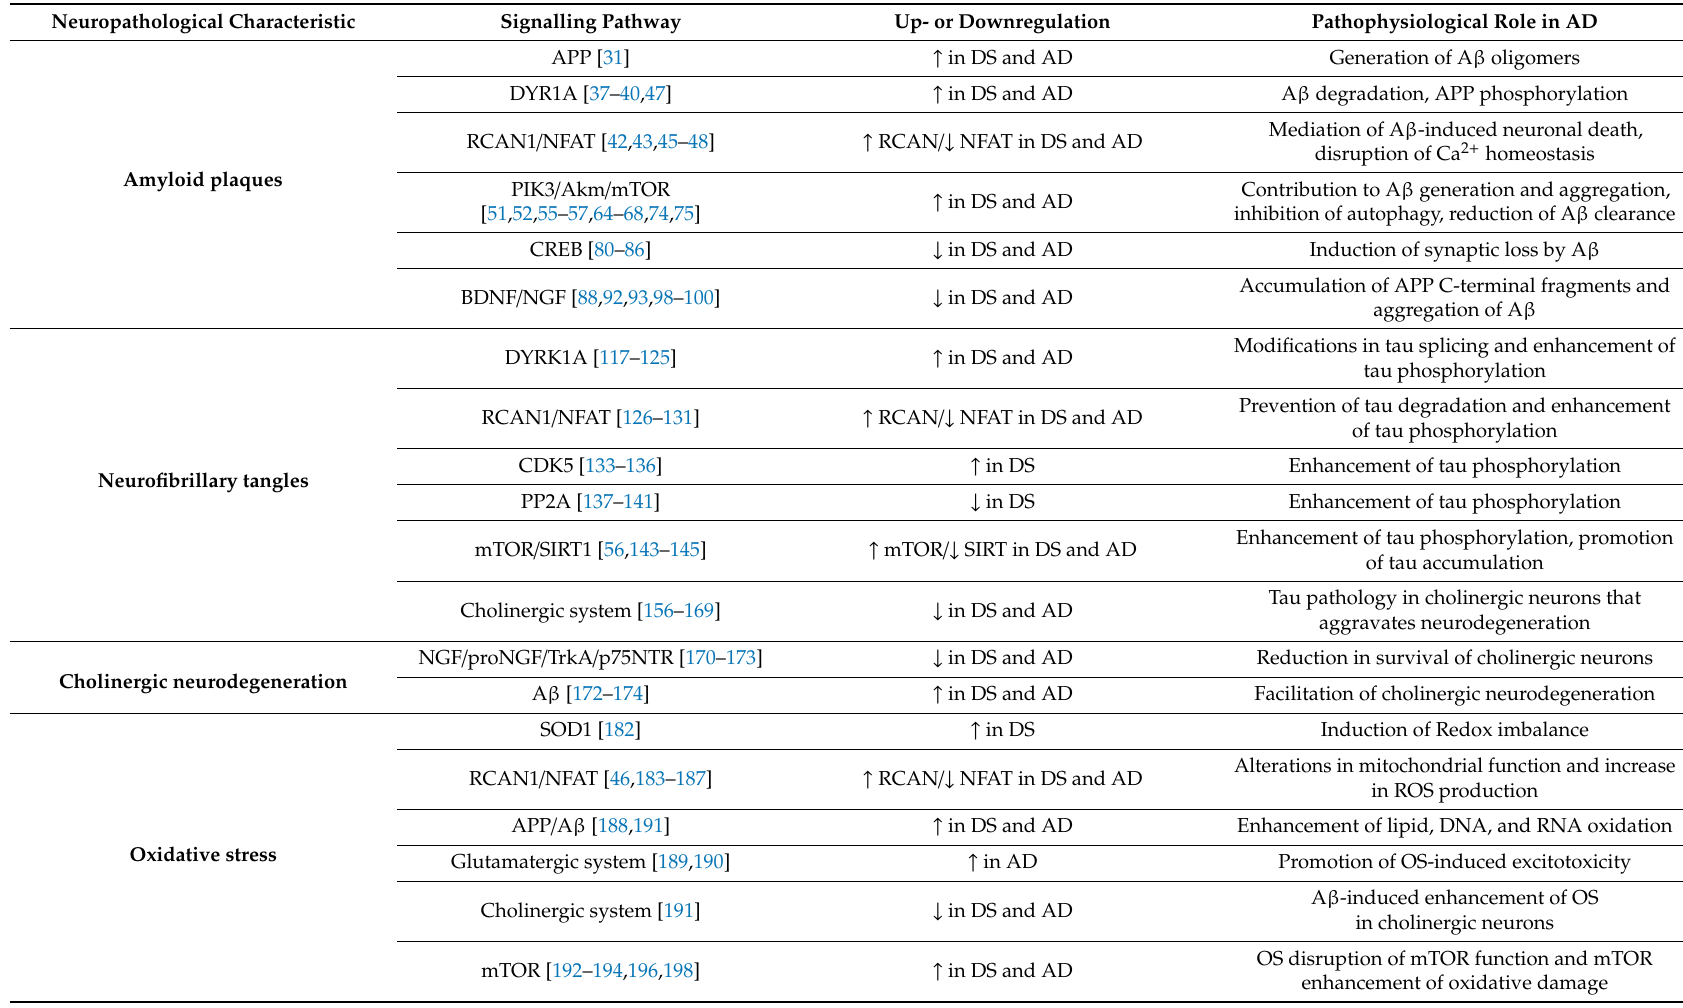
Table 1. Signalling pathways implicated in the main neuropathological characteristics of Alzheimer’s disease in individuals with and without Down syndrome. Neuropathological